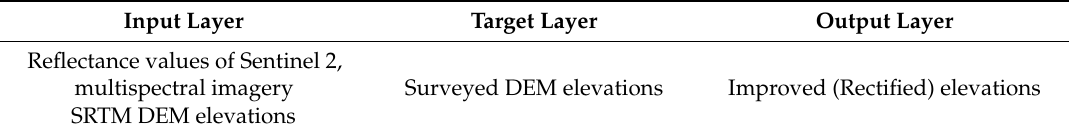
Table 2. Input, target, and output layers in ANN